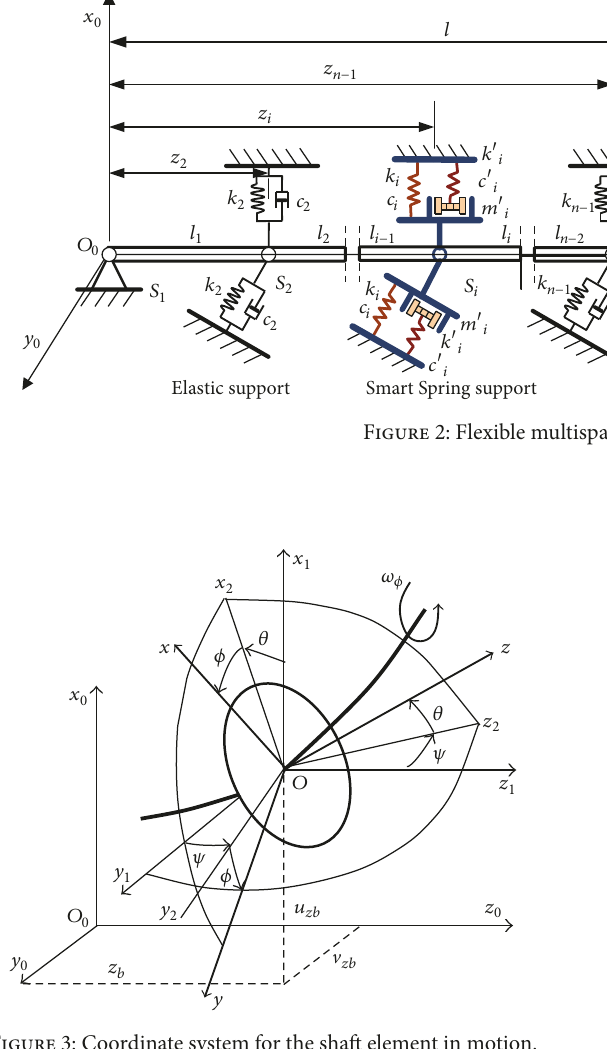
Figure 3: Coordinate system for the shaft element in